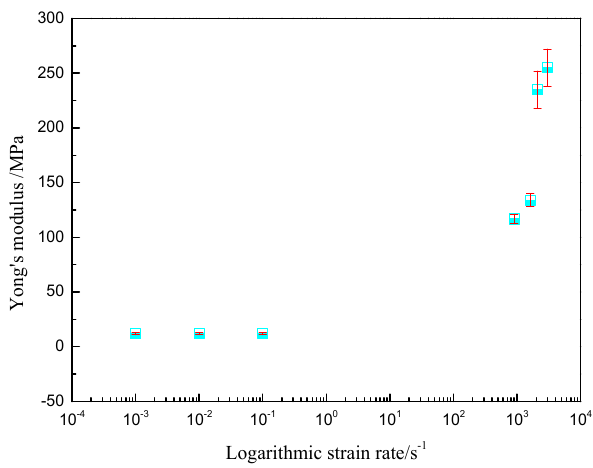
Figure 8. Young’s modulus of polyurea at different logarithmic strain rates.